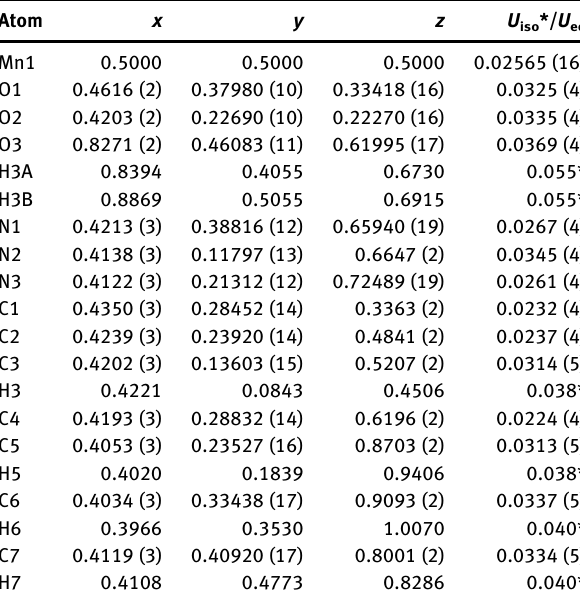
The asymmetric unit of the title crystal structure con- sists of one half of a Mn 2 + ion, one fully deprotonated